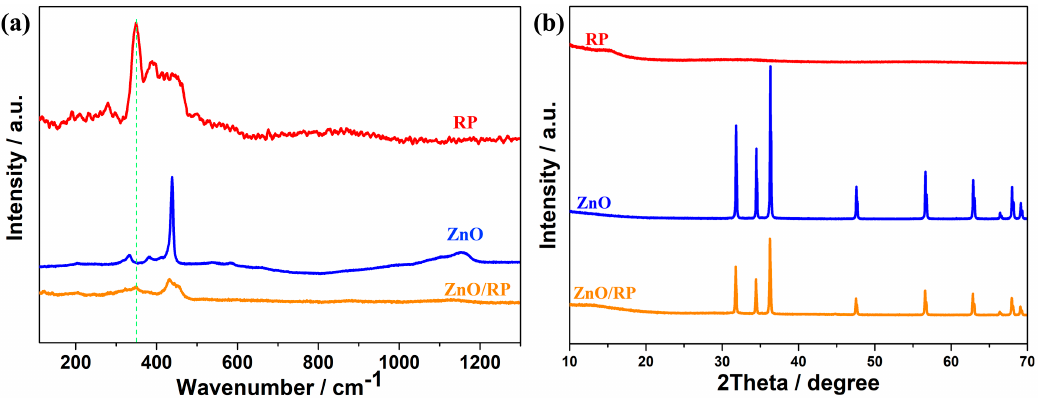
Figure 3. ( a ) Raman spectra of red P, ZnO and ZRP-5; ( b ) XRD patterns of the samples: ZnO, red P and ZRP-5.